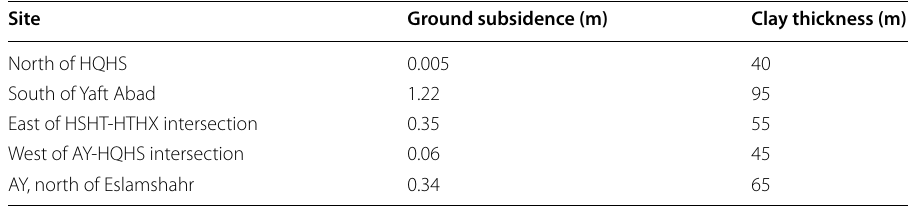
Table 1 Ground subsidence and clay thickness measurements in some locations (1992– 2001)